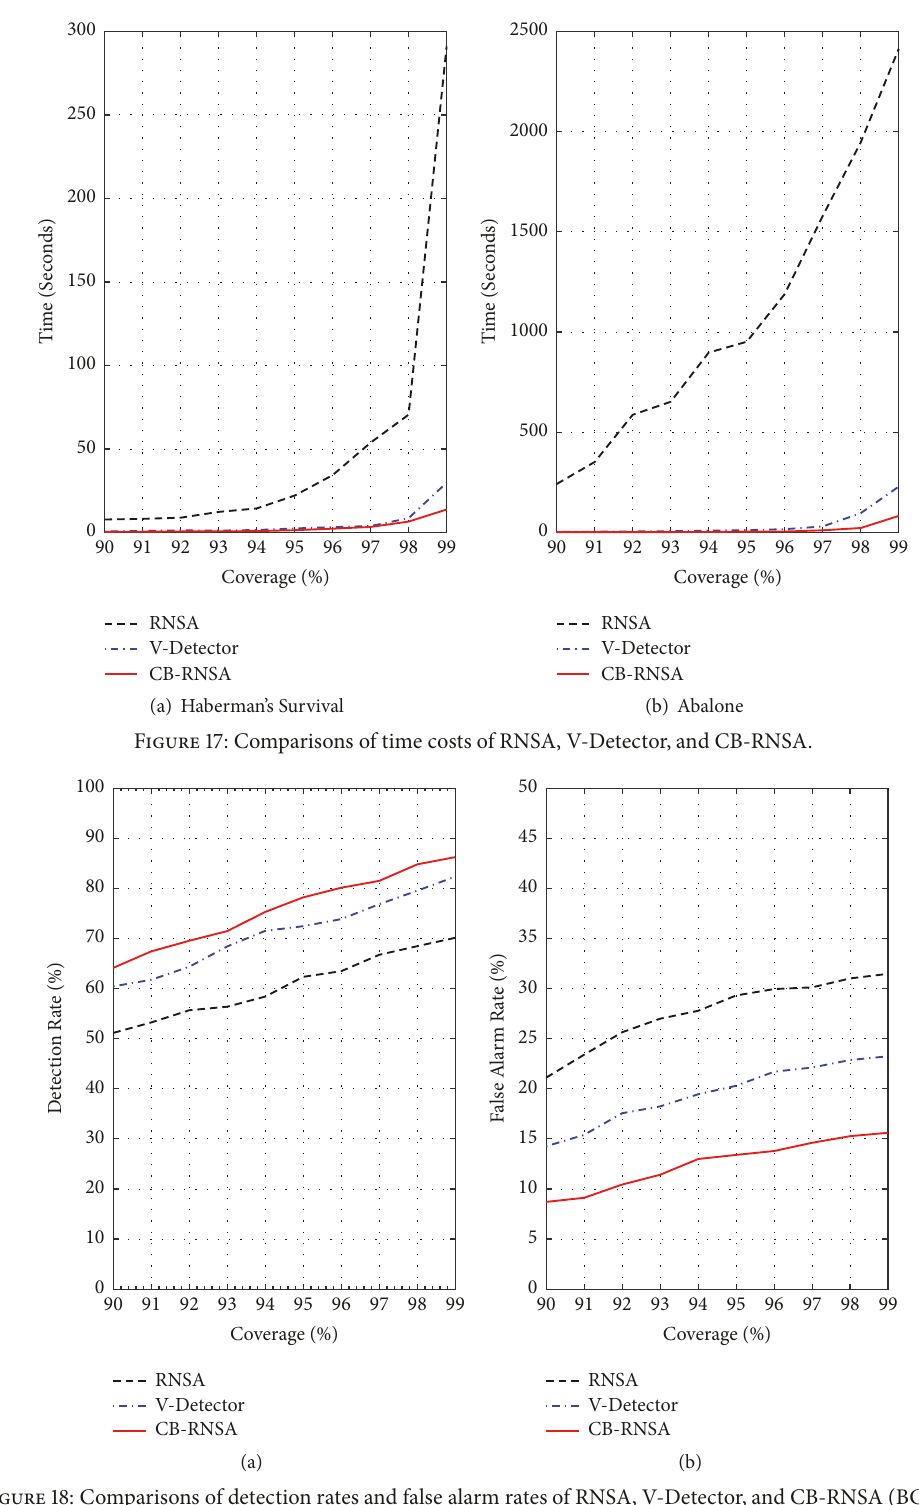
rate of V-Detector is 30.1%, and false alarm rate of CB-RNSA is 20.1% which declines by 63.6% and 33.2%, respectively. For high dimensional data set BCW2, when the expected coverage rate is 99%, false alarm rate of RNSA is